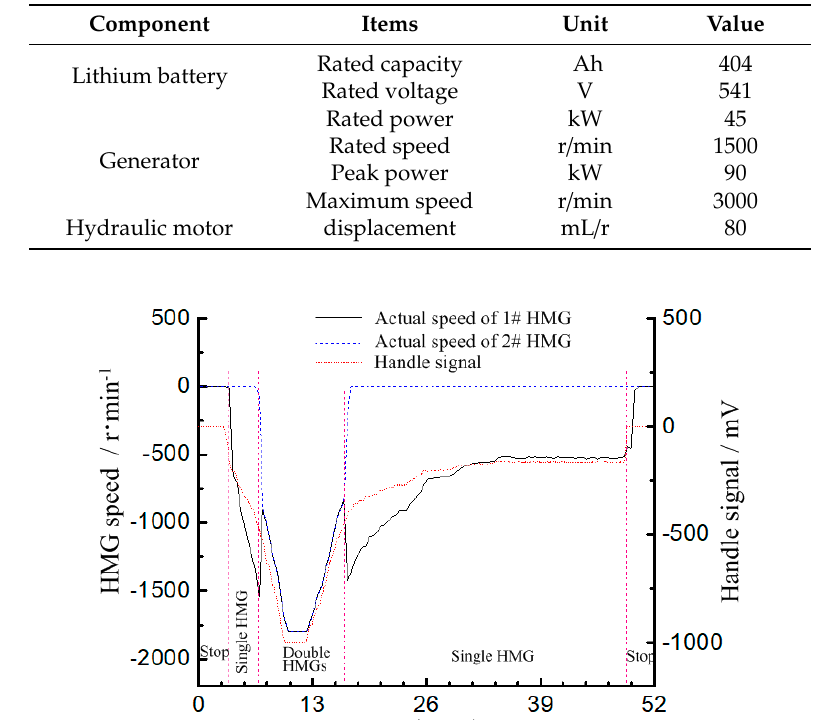
Table 2. Parameters of the key component.